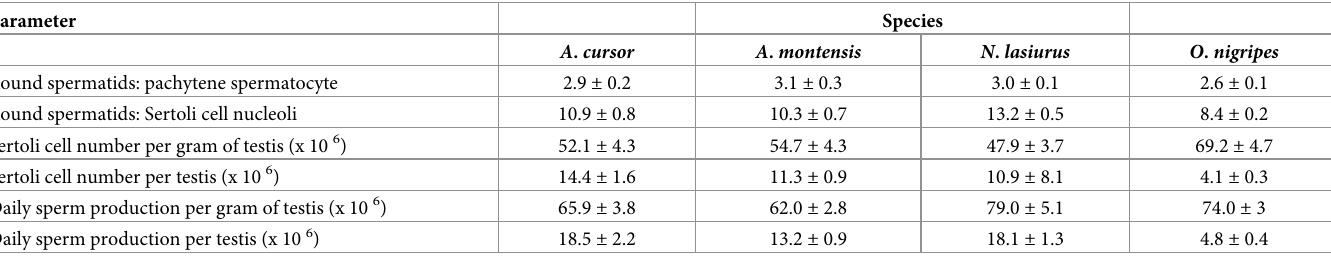
Table 4. Cell ratios and sperm production in A . cursor , A . montensis , N . lasiurus and O . nigripes (mean ±